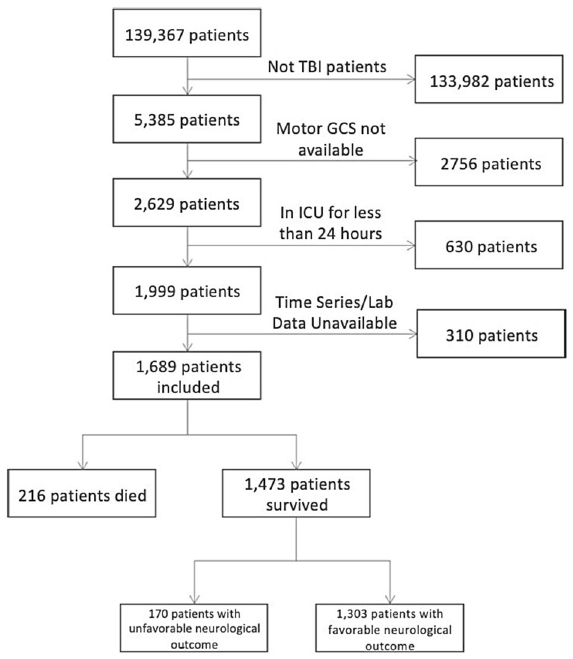
Figure 1. Study flow diagram. Shown are the patient inclusion and exclusion process and the outcomes recorded at ICU discharge.